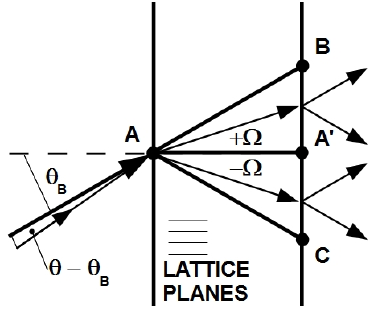
Figure 14. Angle amplification effect. Direction of neutron currents for small deviations from the Bragg